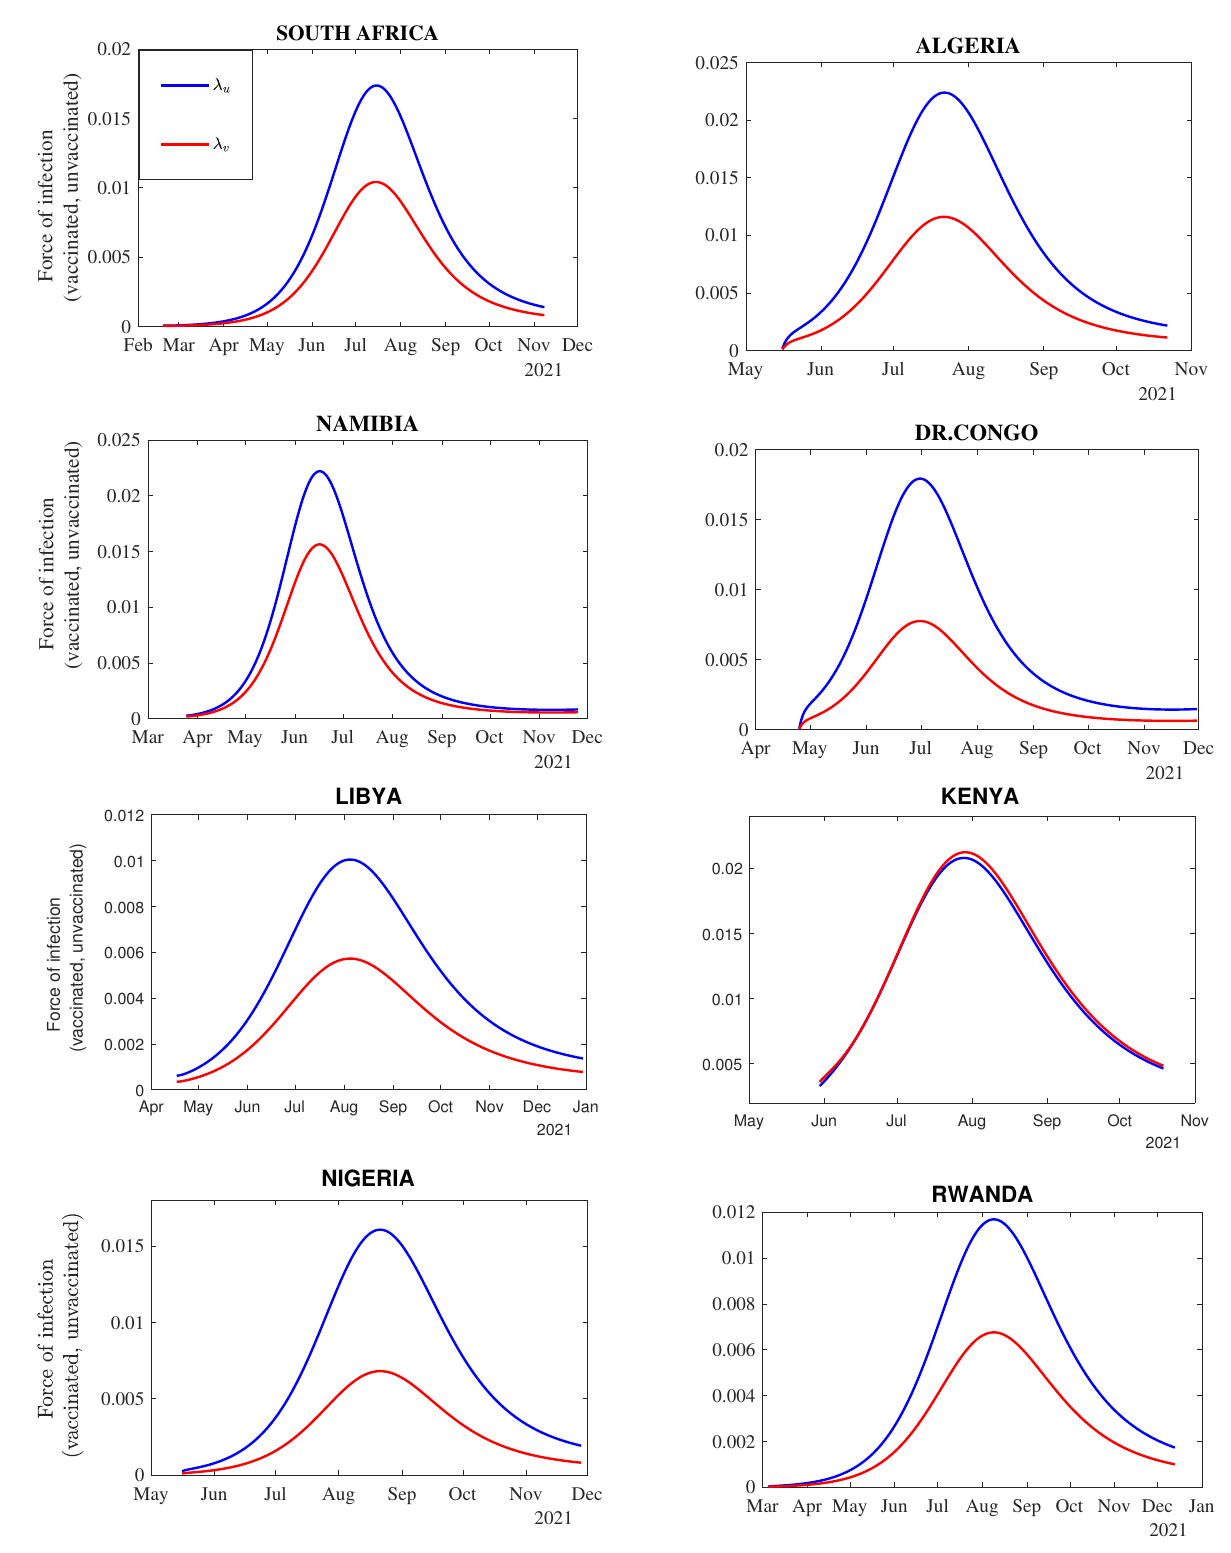
Figure A2. Dynamic trend for the force of infection over time during COVID-19 vaccination. The blue and red curves represent the force of infection for the unvaccinated ( λ u ) and vaccinated ( λ v ) individ- uals,